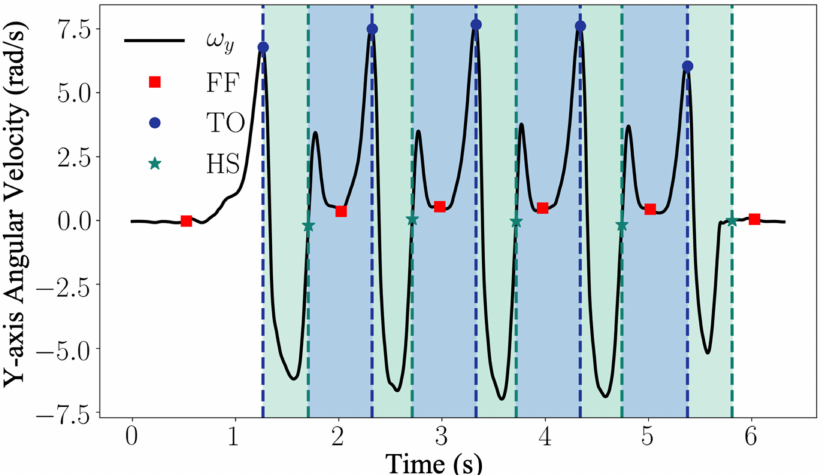
Figure 6. The signal from the gyroscope aligned with the medio-lateral axis of the foot is used for gait event detection. Each stride is characterized by a sequence of FF, TO, HS, and FF as indicated. The green and blue areas refer to the swing and stance phases. The blue and green vertical dashed lines define the starting time frame of the swing and stance phases,